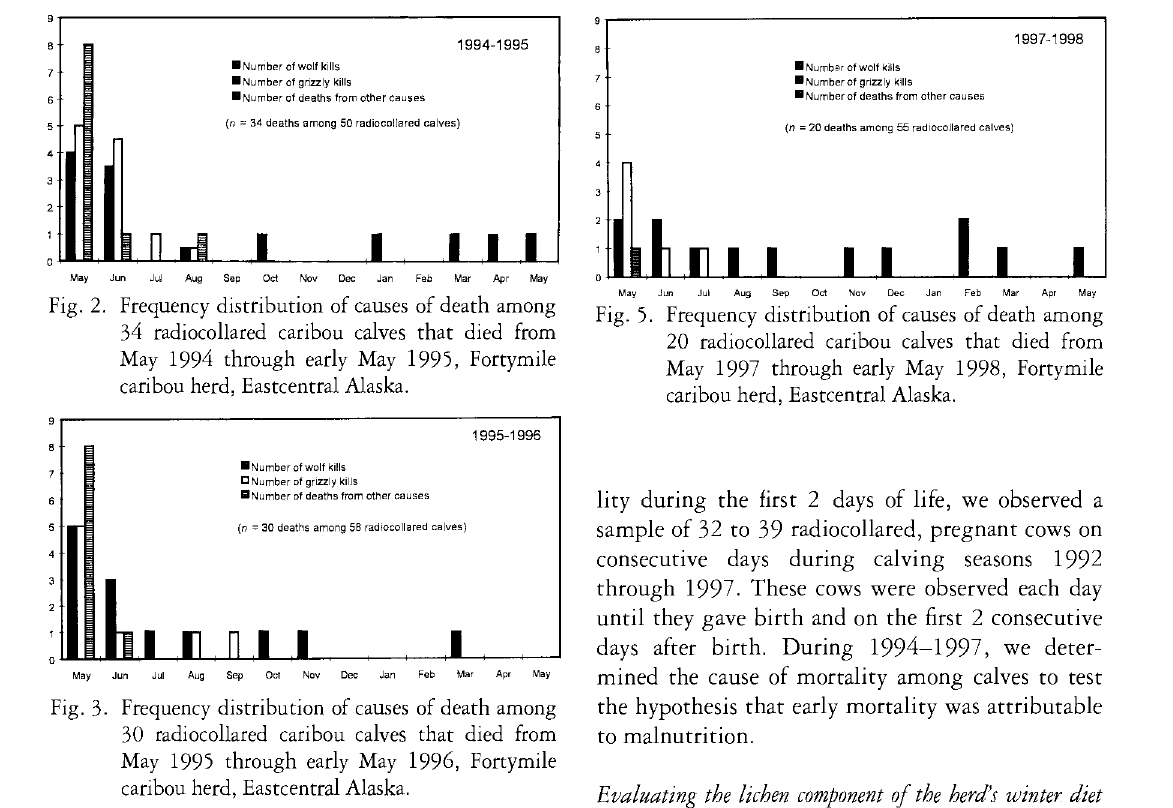
Fig. 4. Frequency distribution of causes of death among 37 radiocollared caribou calves that died from May 1996 through early May 1997, Fortymile caribou herd, Eastcentral Alaska.